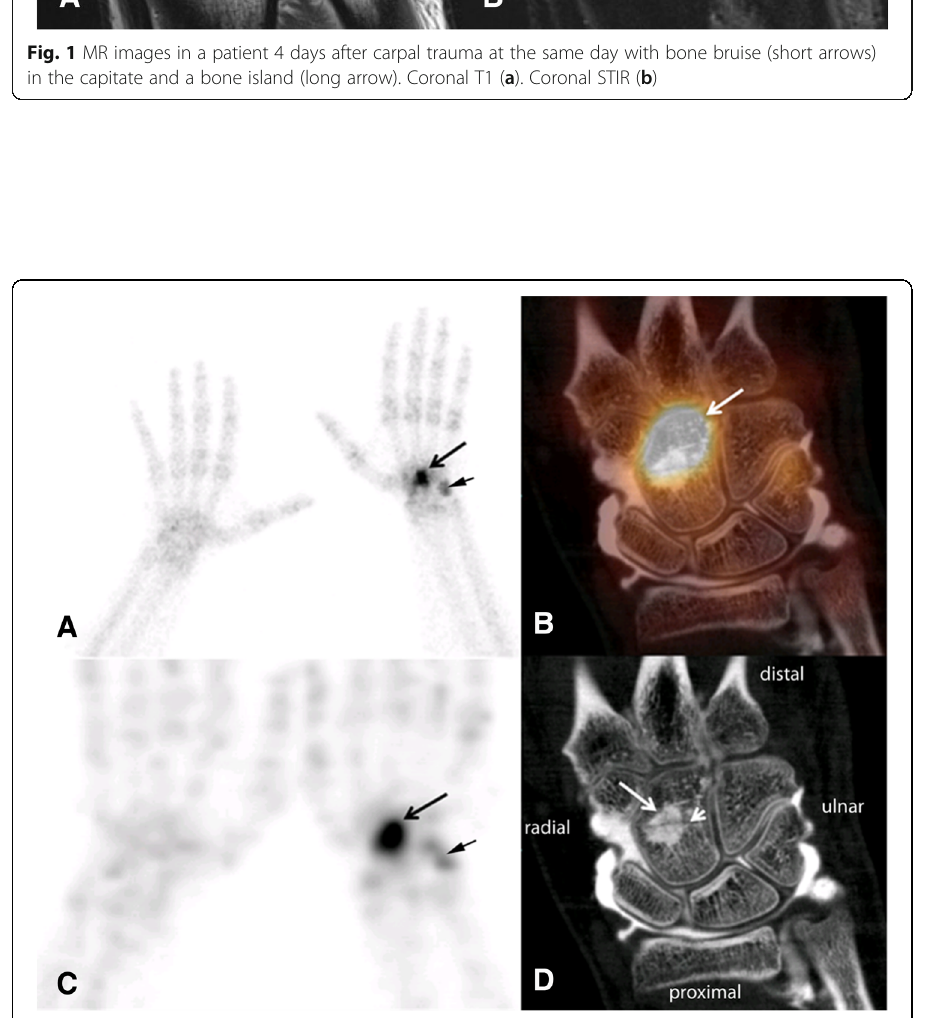
Fig. 2 SPECT/CT arthrography in a patient 1 month after carpal trauma with capitate fracture (short arrow in D) through a bone island (long arrow in D). Planar bone scintigraphy ( a ) SPECT ( c ) and SPECT/CT ( b ) with increased uptake in the capitate (arrow). SPECT/CT arthrography ( b ). CT arthrography ( d ) showing intact ligaments and cartilages. Additionally, slightly increased traumatic uptake in the pisiforme bone (short arrow) is visible on planar images and